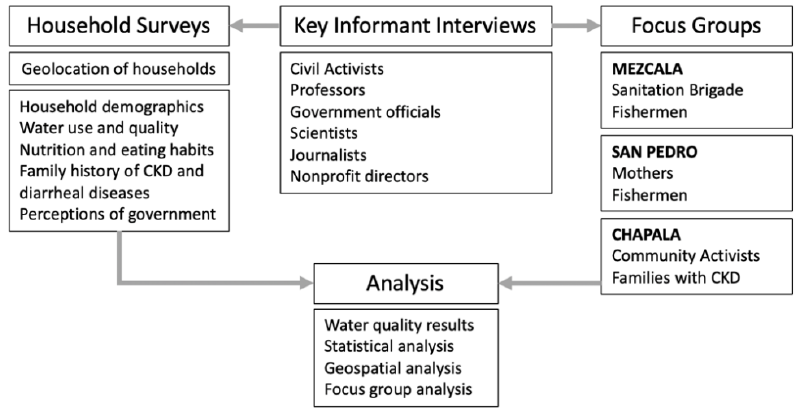
Figure 1. Mixed methods study design.